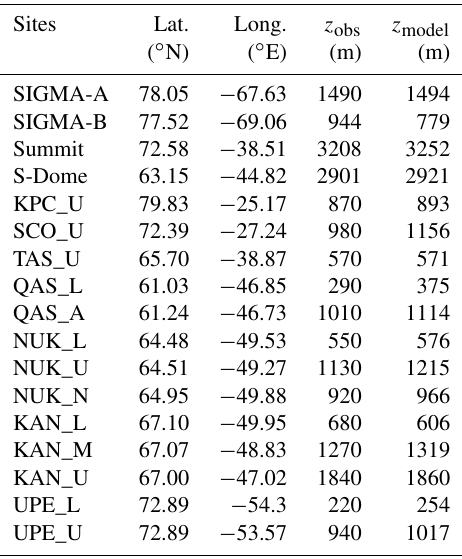
Table 1. Locations of observation sites for surface meteorology, in- cluding surface elevations measured on site ( z obs ) and specified in NHM–SMAP ( z model ). Sites Lat. Long.